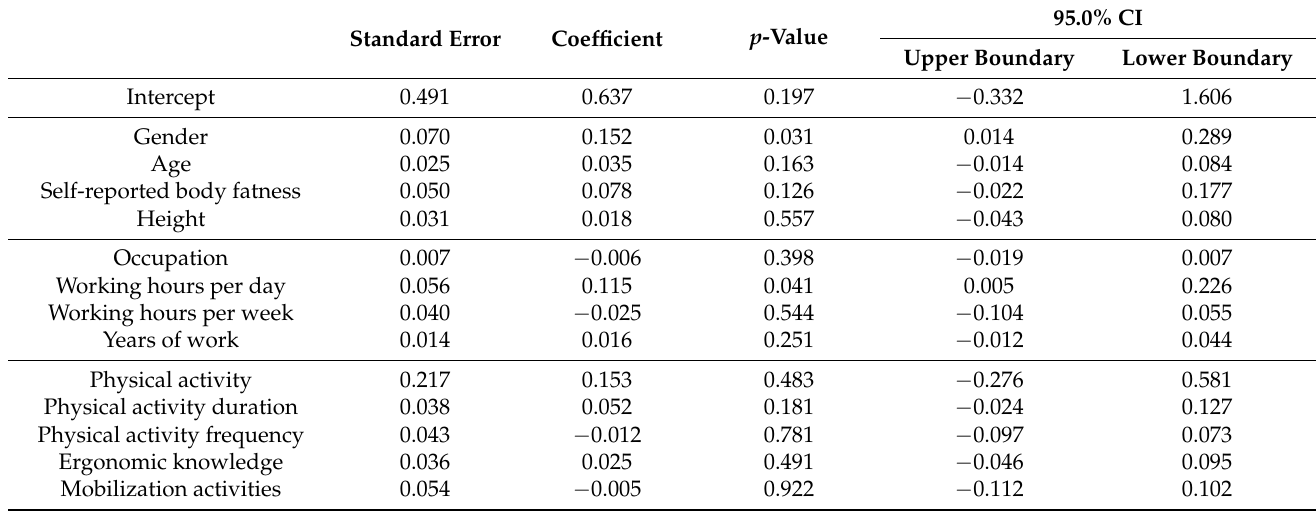
Table 5. Logistic regression of factors in association to WMSD. (statistical significance for p < 0.05). Gender and working hours per day parameters were significantly correlated to WMSD